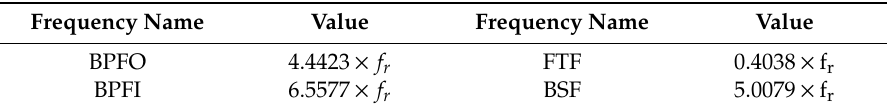
Table 3. Bearing fault frequencies.